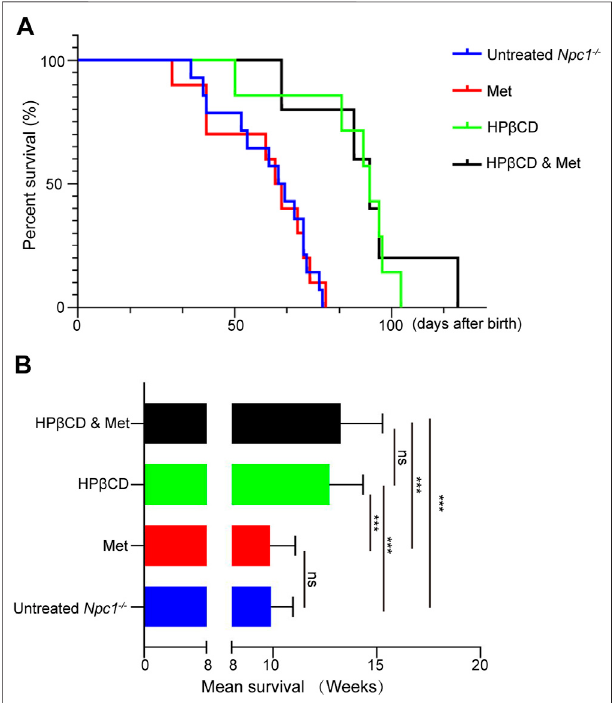
FIGURE 1 | Effect of combination therapies on survival in Npc1 − / − mice. Survival was evaluated applying a late humane end point and is presented as Kaplan – Meier survival plots (A) and mean survival (B) . Statistical analysis is based on one-way ANOVA followed by Tukey test, ns represents not signa fi cant, *** p < 0.001. All data are provided as means ± SEM.